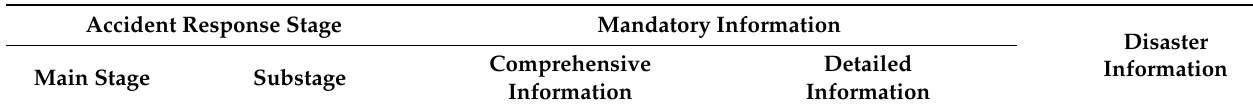
Table 7. Mandatory information for each stage of accident response (e.g., nuclear power plant